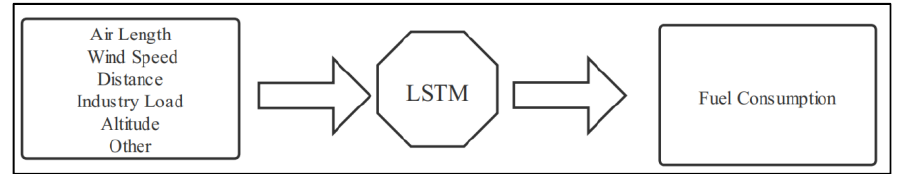
Figure 3. Fuel consumption model processing framework.